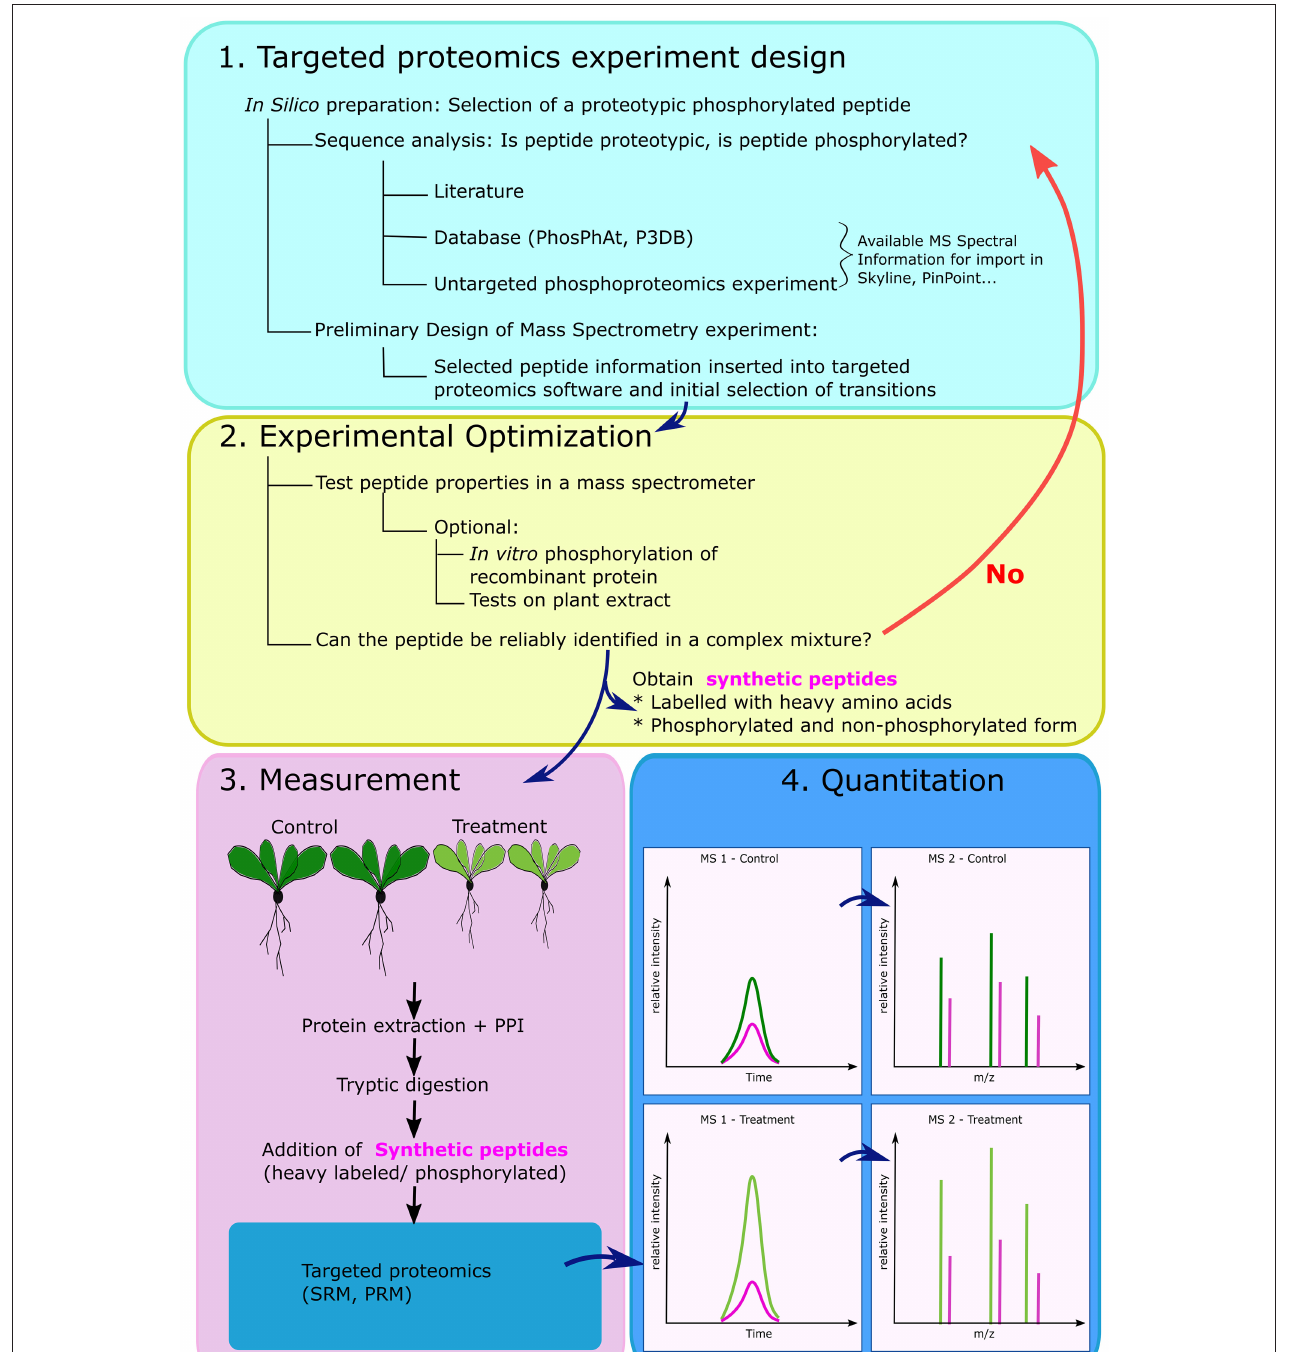
FIGURE 1 | General overview of the steps involved in the creation of a targeted proteomics experiment for monitoring phosphorylated peptides. The experimental design starts with selection of a posttranslationally modified peptide, which needs to meet several criteria: to be proteotypic i.e., unique to a protein, and digestible by a selected protease- usually trypsin. In silico fragmentation is performed and targeted transitions are inserted into specific software (1) . The peptide properties are verified on the MS platform available to the scientist under conditions relevant for the biological investigation. If confirmed, synthetic peptides can be ordered to serve as internal standards for identification and quantitation (2) . After performing the biological experiment, with large number of samples, protein extracts are digested and synthetic peptides in phosphorylated and non-phosphorylated form are spiked in the mixture. Peptides are separated using liquid chromatography and measured on mass spectrometer (3) . Readers are asked to remember that quantitation is possible either in MS1 (e.g., Selected Ion Monitoring), or using selected fragments in MS2 (Selected/Multiple Reaction monitoring) (4) . PPI- protease and phosphatase inhibitors, SRM- selected reaction monitoring, PRM-parallel reaction monitoring. In (4) the colors refer to: control sample peptide (dark green), treated sample peptide (light green) and synthetic peptide (pink).